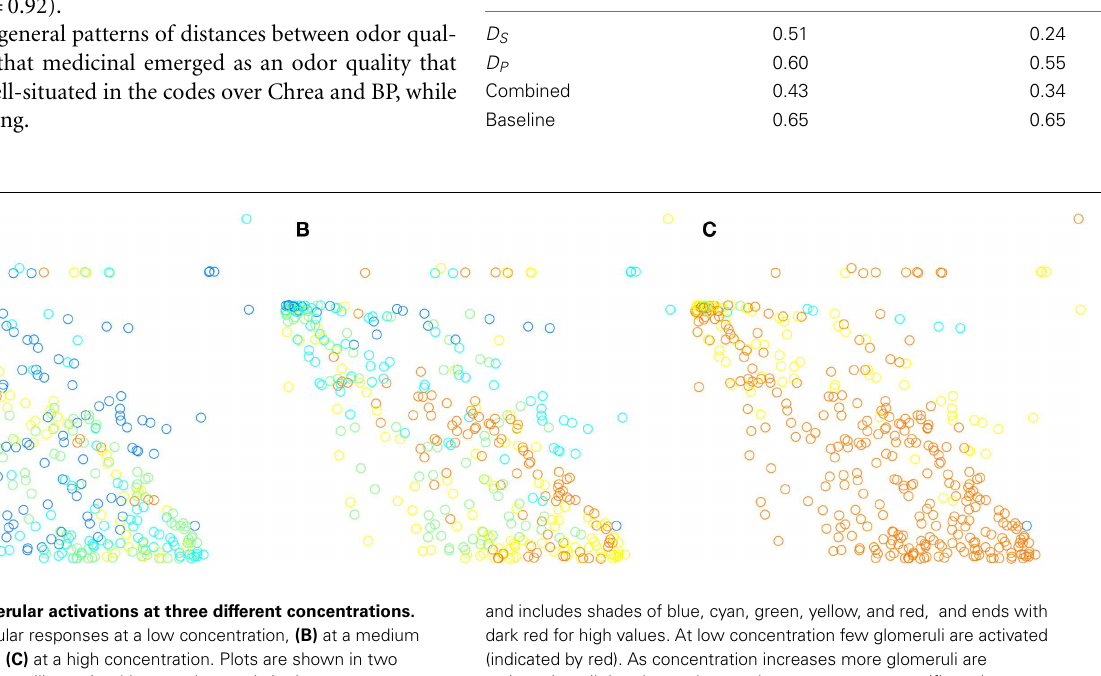
and includes shades of blue, cyan, green, yellow, and red, and ends with dark red for high values. At low concentration few glomeruli are activated (indicated by red). As concentration increases more glomeruli are activated, until the glomerular map becomes very unspecific and